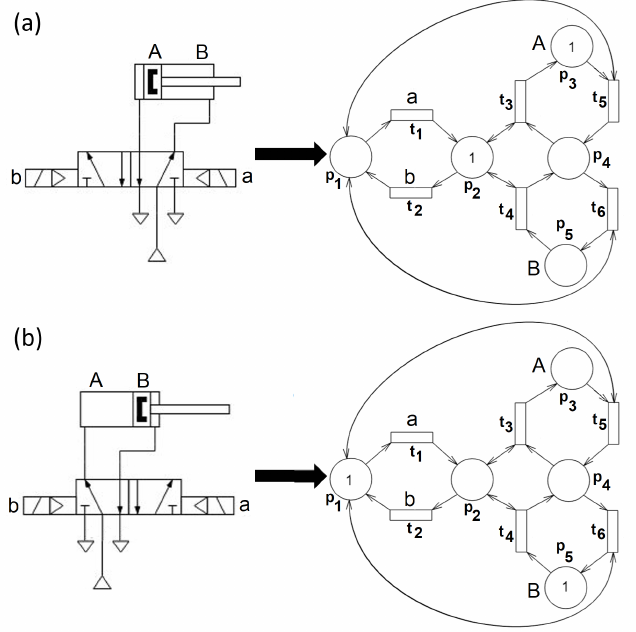
Figure 1. IPN model for an electro-pneumatic assembly: ( a ) the pneumatic actuator is retracted; ( b ) the actuator is